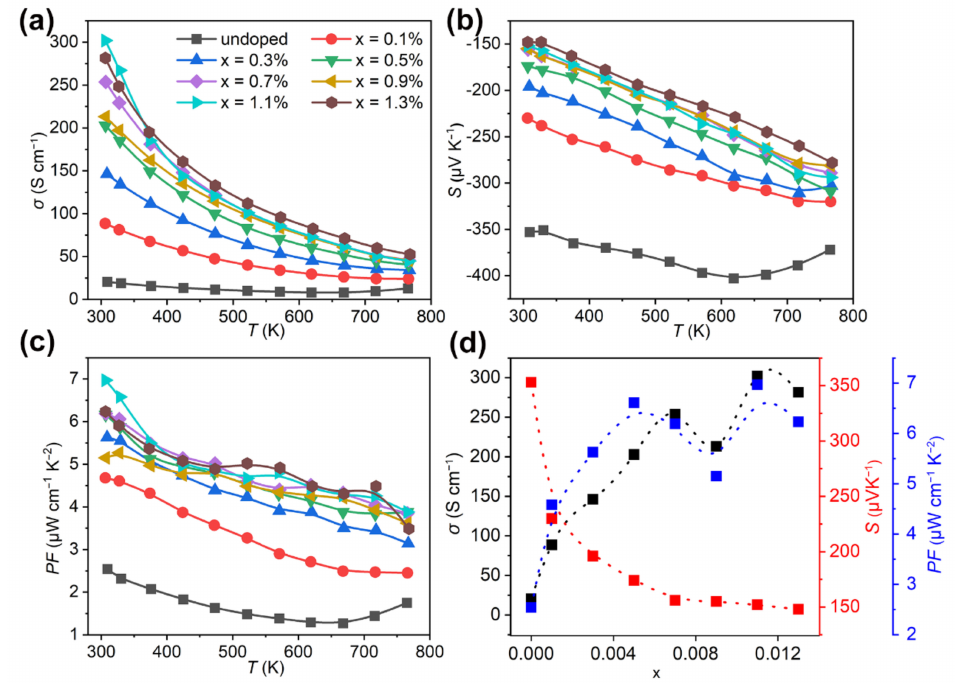
Figure 3. Temperature dependence of ( a ) electrical conductivity ( σ ), ( b ) Seebeck coefficient ( S ) and ( c ) power factor ( PF ) for Bi 2 Se 1 − x I x S 2 (x = 0–1.3%). ( d ) Change of electrical transport parameters ( σ , S and PF ) with doping level at room